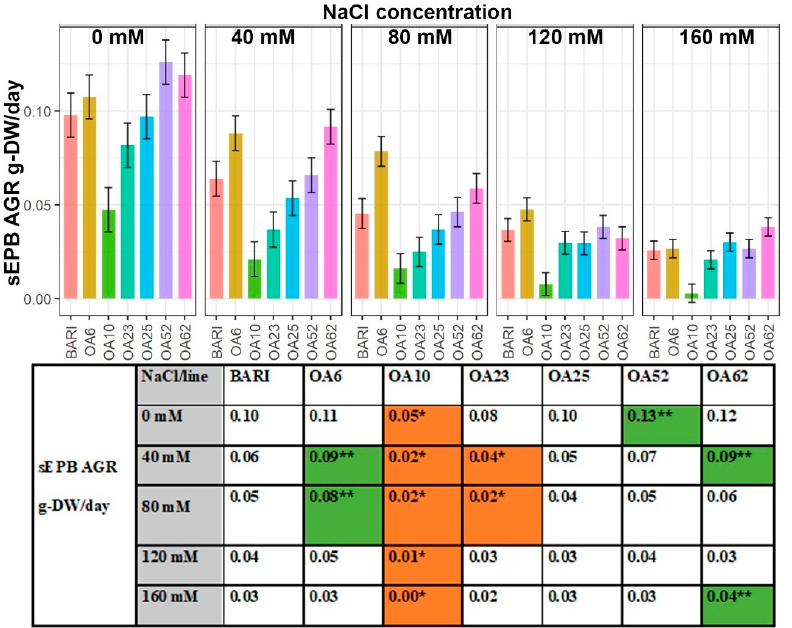
Figure 1. Absolute growth rate of estimated plant biomass (sEPB AGR) in interval DAP 32–38. Data are shown for the control BARI Gom-25 (BARI) and mutagenized wheat lines OA6, OA10, OA23, OA25, OA52, and OA62 in interval DAP 32–38. NaCl concentrations applied were in the range from 0 mM to 160 mM. Upper panel: sEPB AGR values with half-LSD error bars. Lower panel: table high-lighting the sEPB AGR mean values with color codes for significantly higher (dark green **) or lower (orange *) values compared to BARI Gom-25, p ≤ 0.05.